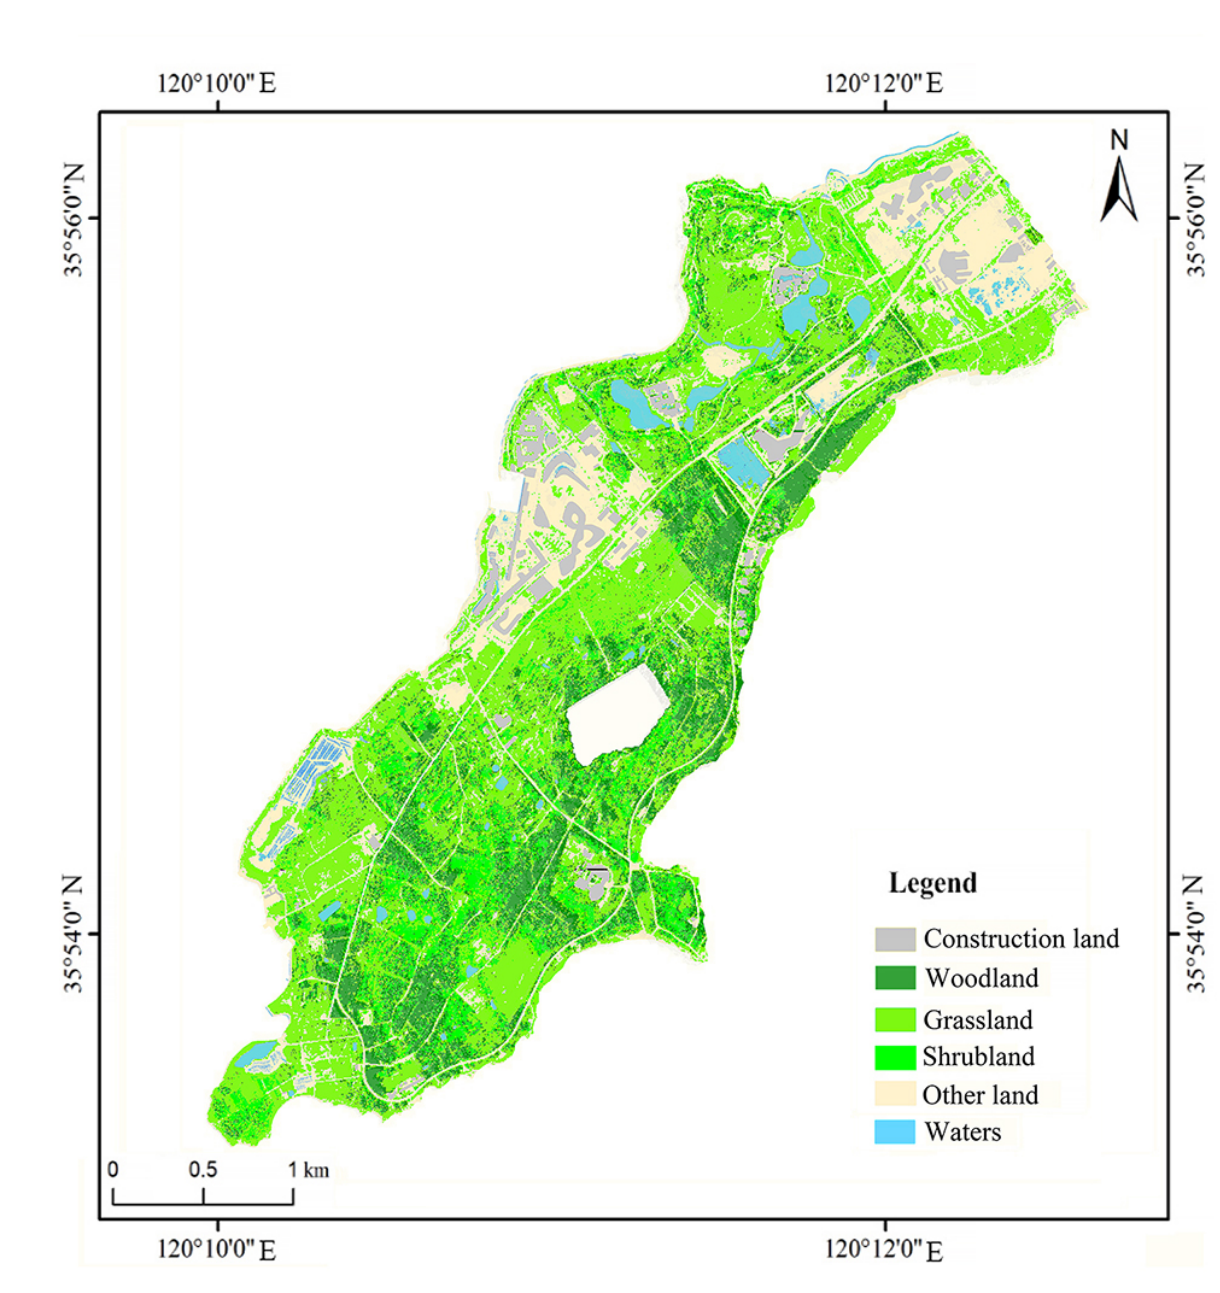
Figure 2. Land use classification map of southern